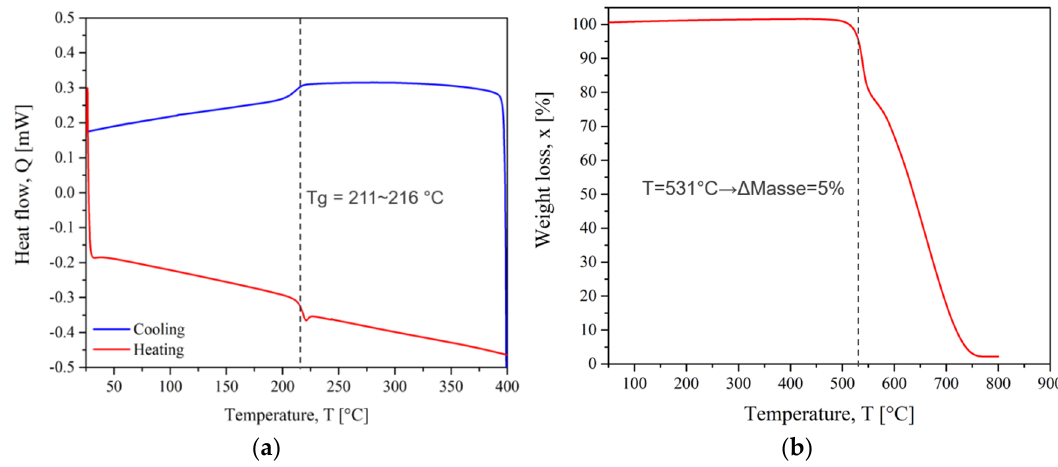
Figure 7. PEI thermograms ( a ) DSC and ( b ) TGA.